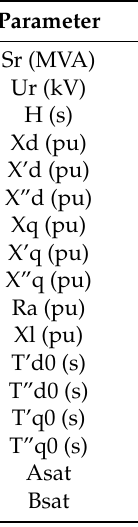
Table A1. Parameters of synchronous machine—subtransient